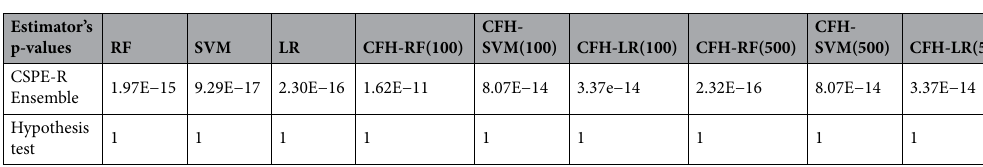
Table 6. Paired t-test comparison with base estimator on test